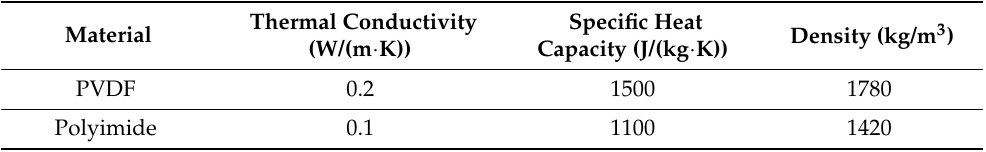
Table 3. Mechanical properties of MEMS